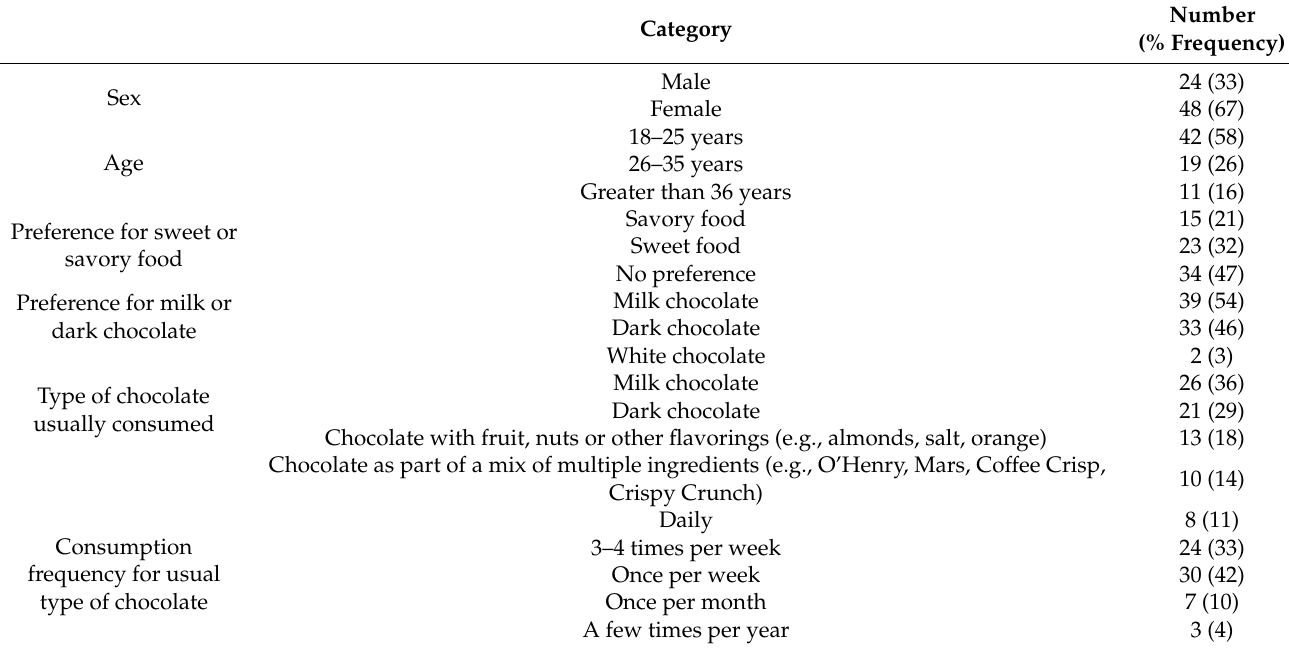
Table 2. Demographic and product use results of the consumer panelists ( n =